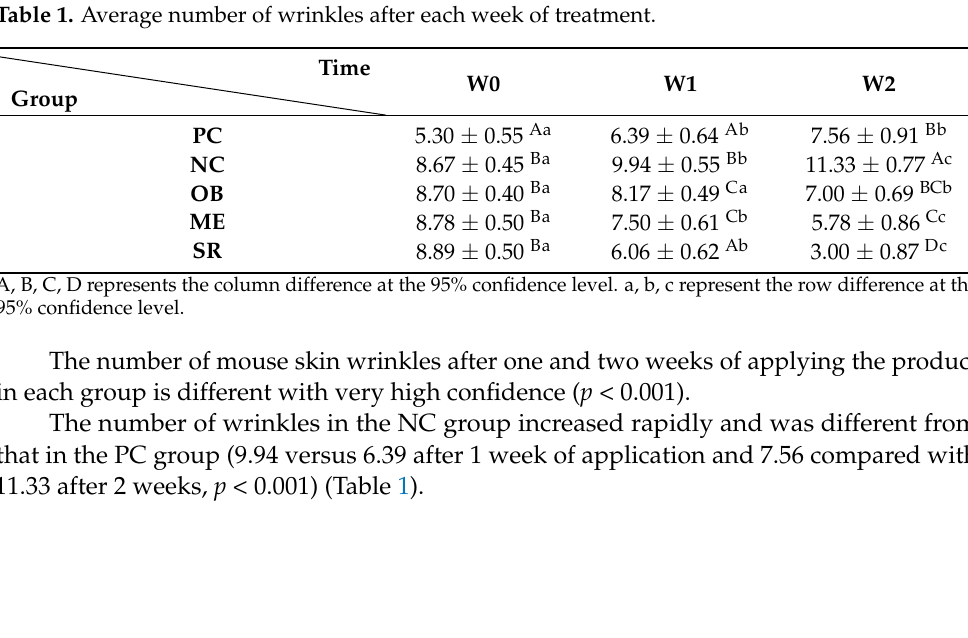
Table 1. Average number of wrinkles after each week of treatment.